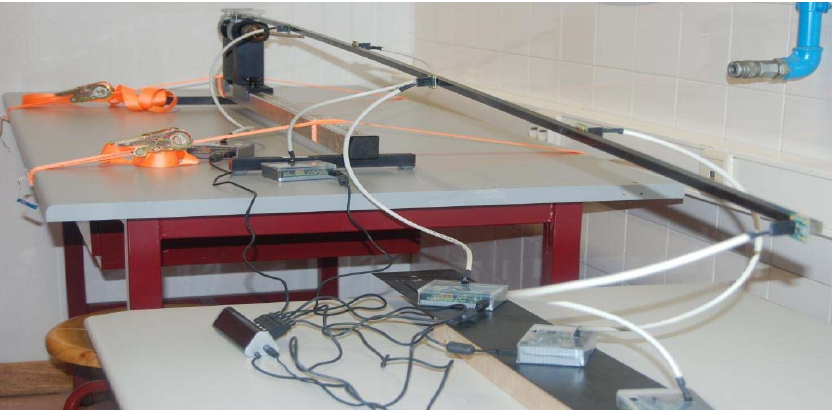
Figure 13. Test bench for the deflected beam: accelerometers and IS modules are visible.